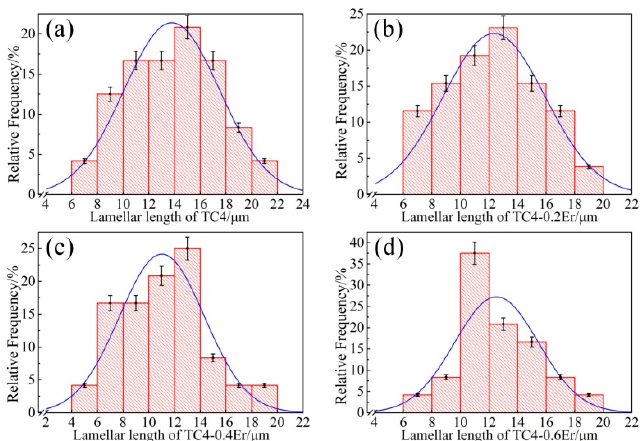
Figure 5. Size distribution of the lamellar length of Ti6Al4V- x Er casting alloys: ( a ) x = 0; ( b ) x = 0.2; ( c ) x = 0.4; ( d ) x = 0.6 wt %.